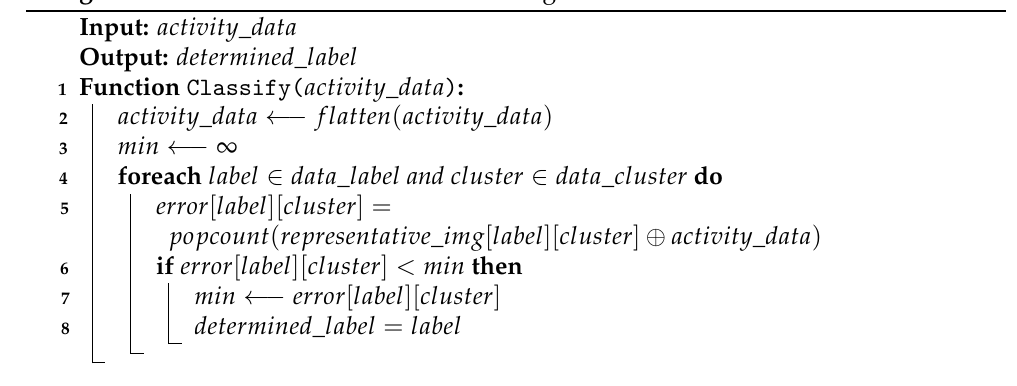
Algorithm 3: Pseudo code of classification algorithm